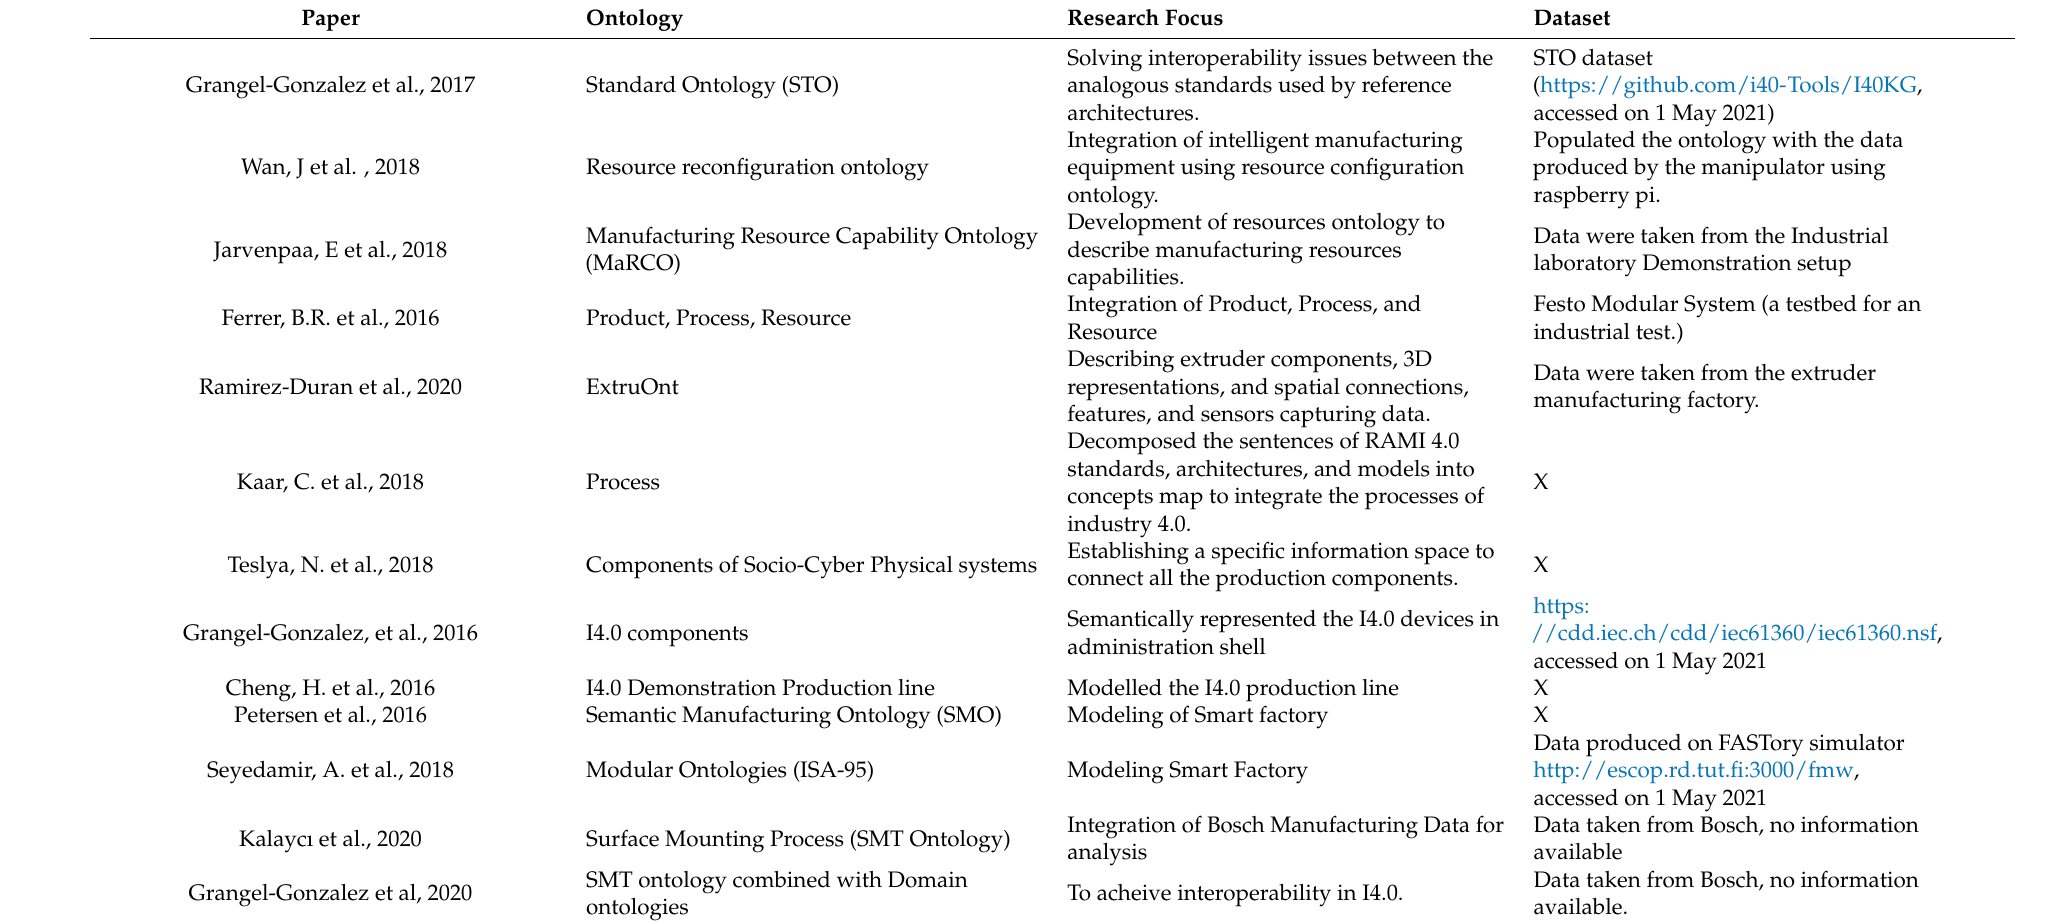
Table 3. Research focus, datasets of identified